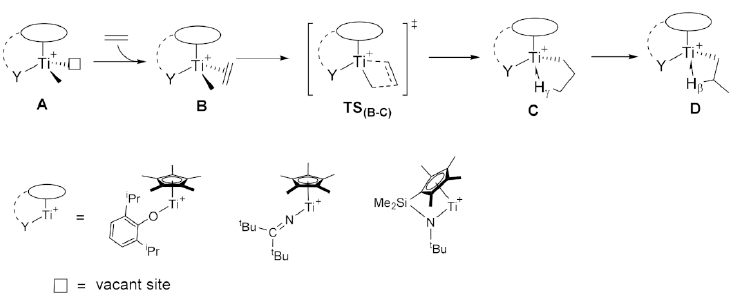
Figure 2. The proposed initiation process of ethylene polymerization initiated by